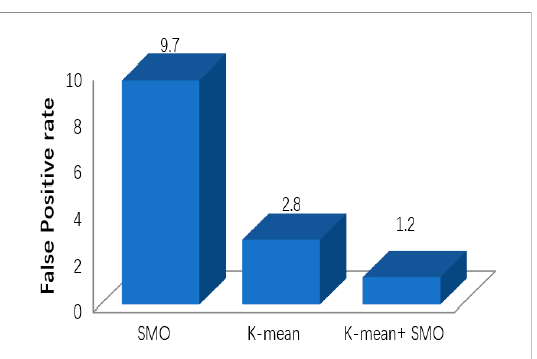
Figure 10. Comparison of false-positive rates for K-mean, SMO, and SMO jointly with K-mean data mining.